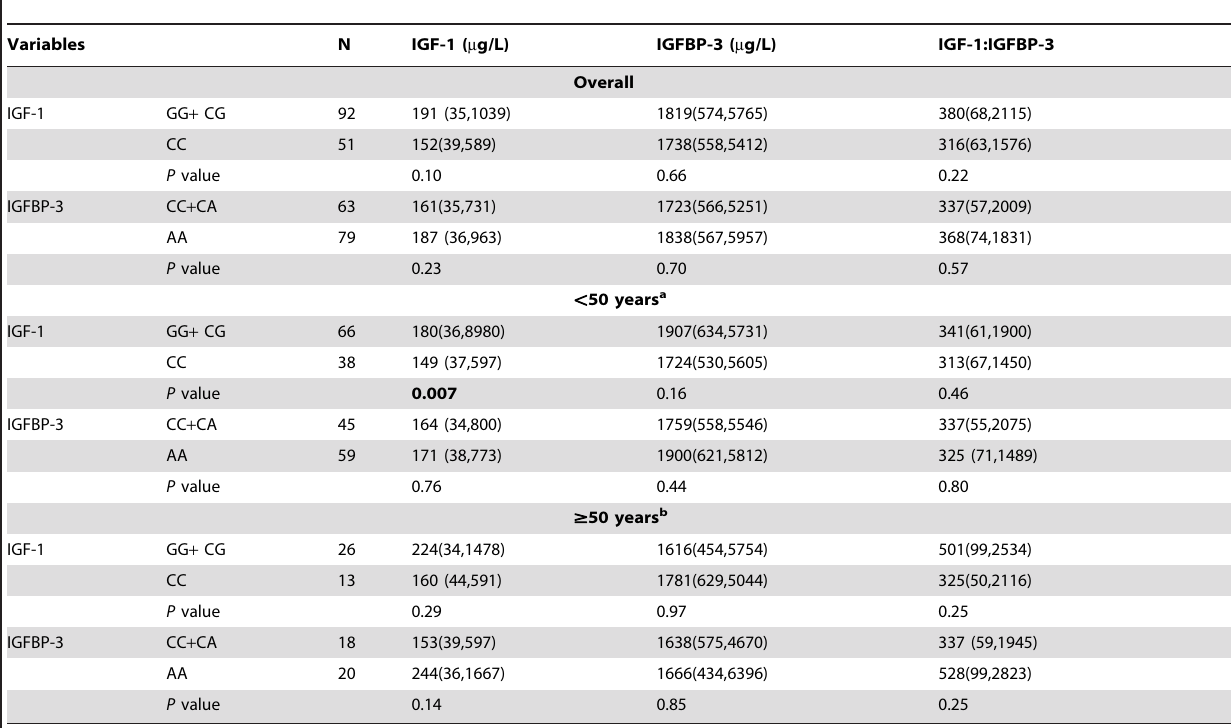
Table 3. Relationship between geometric mean (95% CI) of insulin-like growth factor component levels with IGF-1 and IGFBP-3